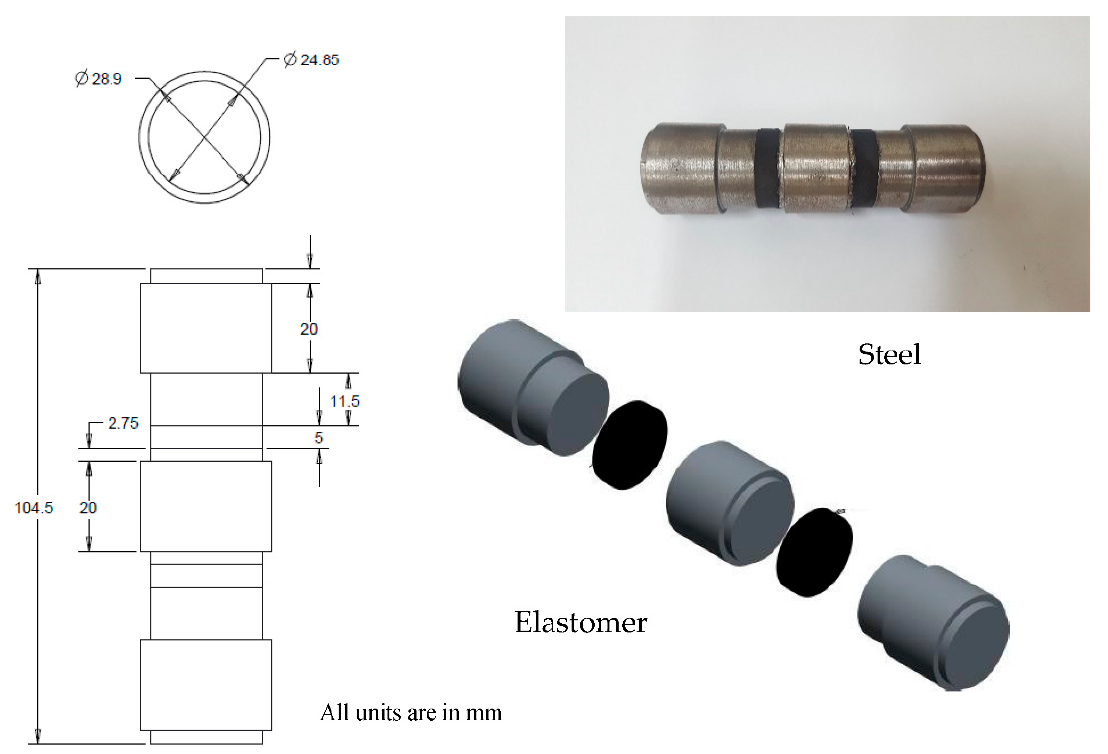
Figure 1. Configuration of double-shear test sample.